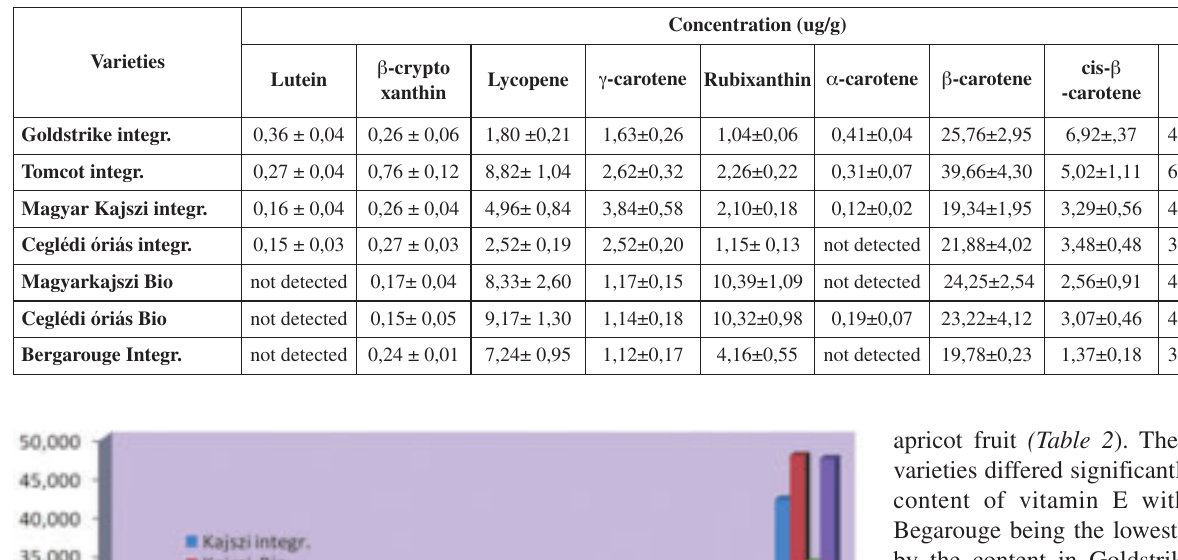
Table 1. Carotenoid composition and content of different apricot varieties grown under organic and integrated farming conditions